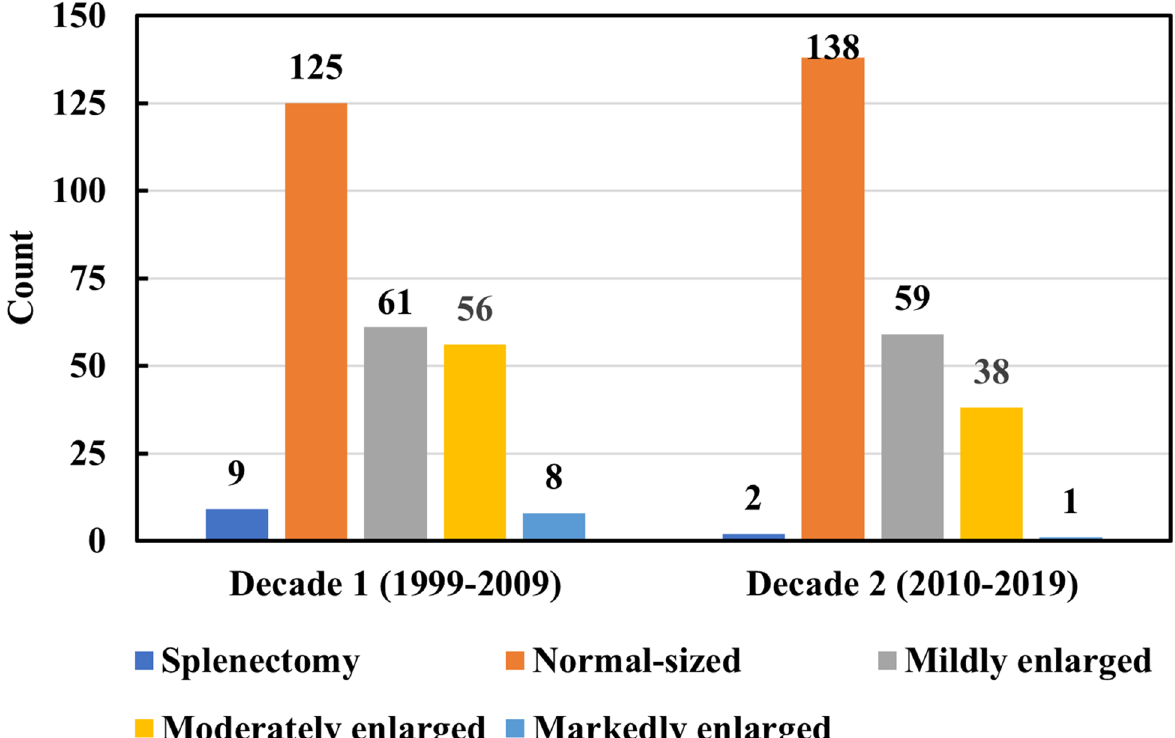
Fig. 9 Ultrasonographic criteria of spleen in both decades involved in study Fig. 9 showed that, splenectomy & huge spleen were statistically significantly higher in 1 st decade while normal-sized spleen was statistically significantly higher in 2nd decade